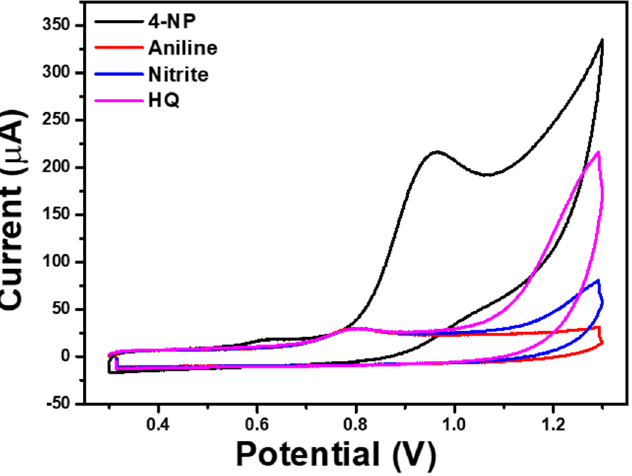
Figure 12. CV responses of Ag-ZnO/GCE in 500 µM 4-NP containing with 500 µM aniline, nitrite, hydroquinone in 0.1 M PBS (pH = 7) solution. (Accumulation time: 2 min, catalyst loading volume: 10 µL). Table 1. Sensitivity comparison of the Ag-ZnO/GCE electrode on 4-NP.